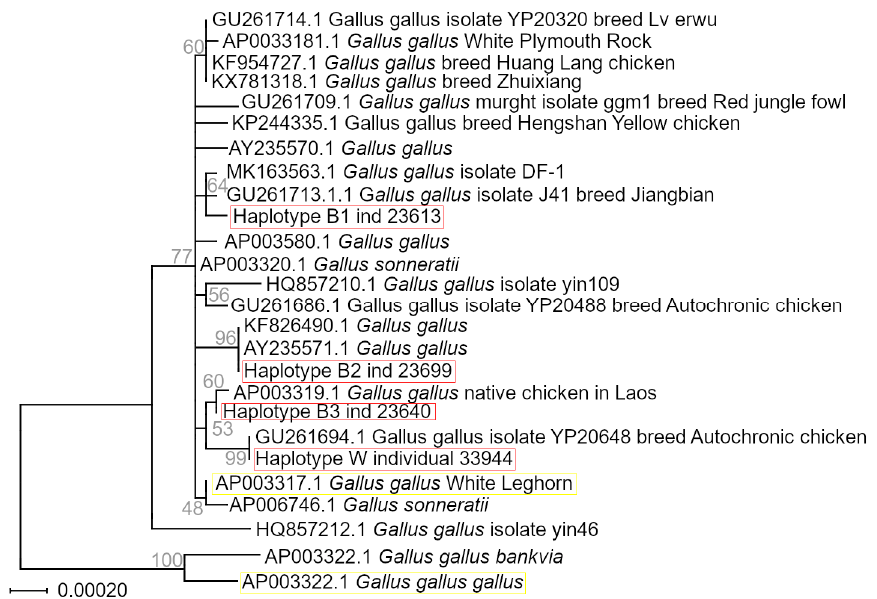
Figure A1. Maximum likelihood tree based on 26 mitochondrial genomes. The tree is based on Hasegawa–Kishino–Yano model including gamma distribution with 200 bootstrap replicates and includes all sites. The alignment was generated with clustalo [81,82], the tree was generated in MEGA X [43]. The tree includes all four detected haplotypes (red), the references used for mapping and validation (yellow) and the five genomes with the highest sequence identity with each haplotype using BLASTn search [83]. Sequences which were under the top five for several haplotypes were only included once and the next highest hits were used to fill up to the final number of five sequences per haplotype.